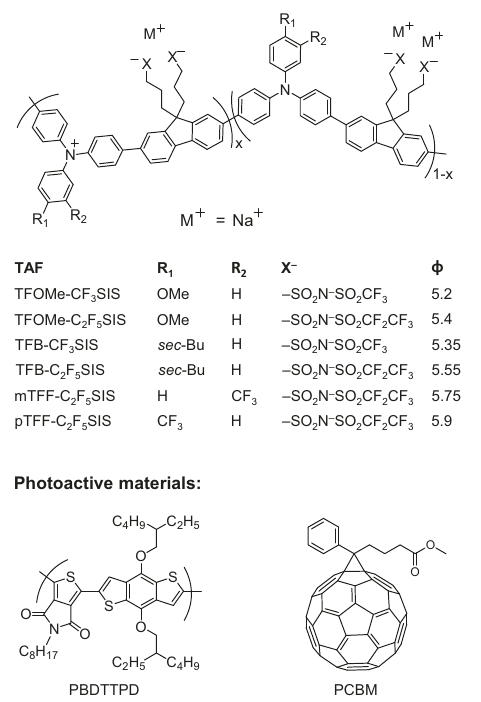
Fig. 1 Chemical structure of photoactive layer and TAF materials. The value of x denotes doping level of the triarylamine – fl uorene (TAF) polymers, in hole per repeat unit: x can vary between 0 (undoped) and 1 (fully doped). The value of x is 0.7 – 0.8 for all TAF polymers studied here. ϕ is vacuum work function given in eV (±0.05 eV), measured by ultraviolet photoemission